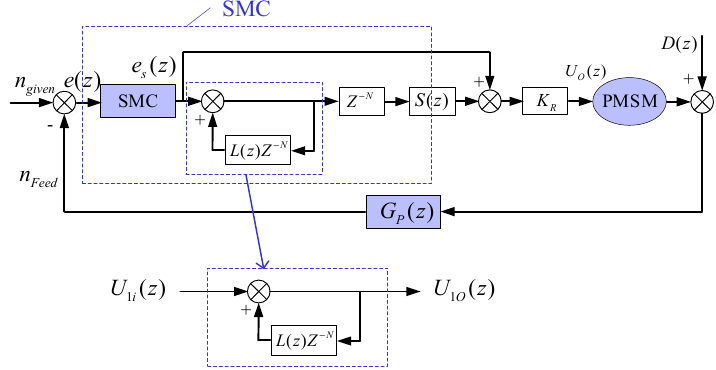
Figure 2. Block diagram of the improved ding mode control (SMC) strategy.